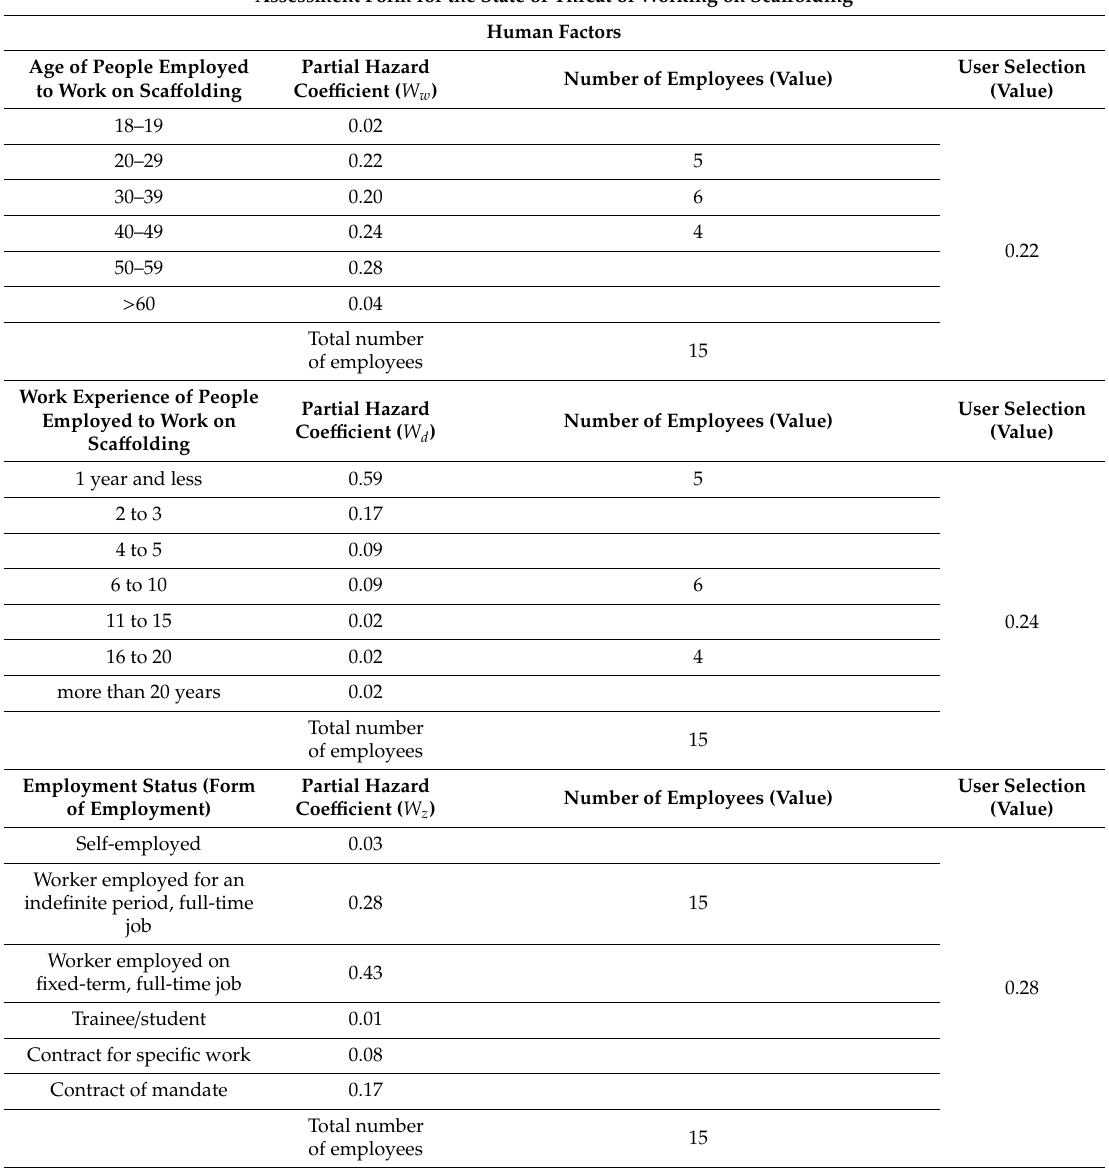
Assessment Form for the State of Threat of Working on Sca ff olding Human